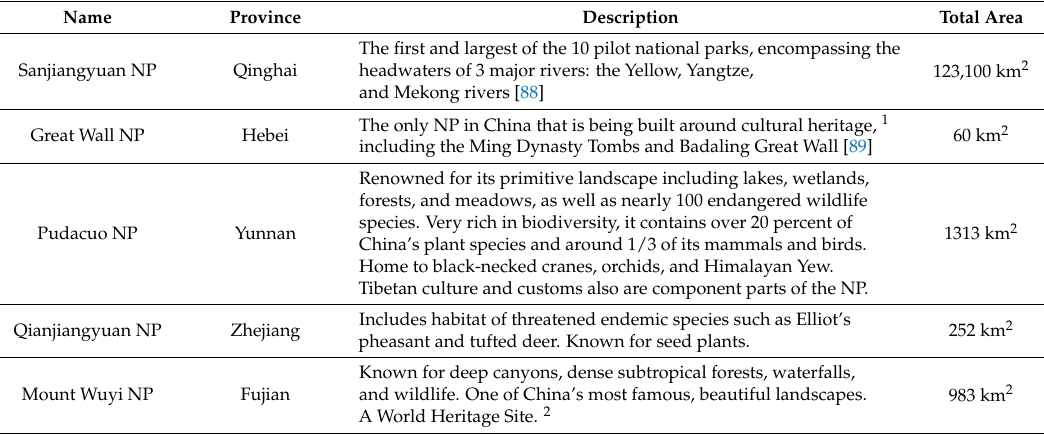
Table 1. National Parks (NP) in trial development phase in China’s new national parks